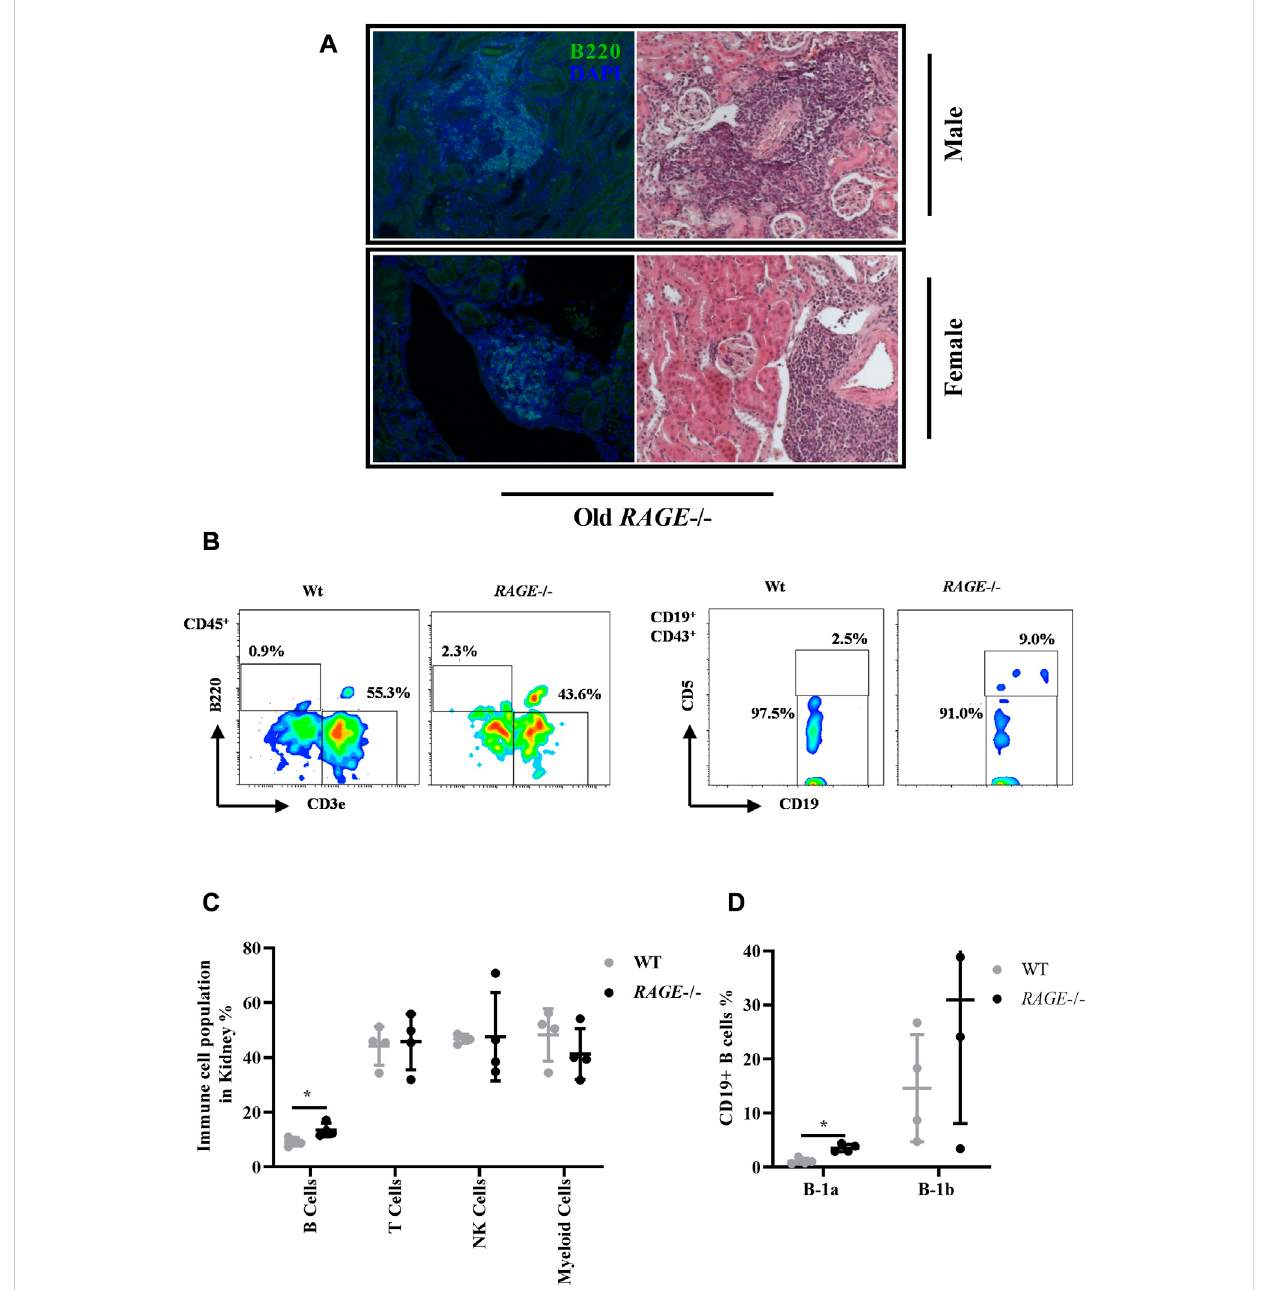
FIGURE 3 Immunecellpro fi lingofkidneytissues: (A) representativeimagesofmassivein fi ltratesinthekidneysfromoldRAGE − / − male(upperpanel)andfemale (lower panel) mice, and the in fi ltrates are stained positive for B-cell marker b220 left (green) and right. H&E of the same animal. (B) Immune cells were isolated from the whole kidney and analyzed by FACS from 62 – 68 weeks old wild type and RAGE − / − ( n = 4) (male and female combined) mice. RepresentativeFACSplots. (C) Quanti fi cationofBcells(B220),Tcells(CD3),NKcells(NK1.1),andmyeloidcells(CD11b).Populationswerecalculated as % of live CD45+ as parent gating. (D) B cells were further analyzed for B-1a (CD19+, CD43+, and CD5+) and B-1b (CD19+ and CD43+) subtypes. Population was calculated as % of live C19+ as parent gating. B220, CD19, and B-1a B cells are the dominant population in RAGE − / − , and p -values were calculated by the non-parametric t -test (Mann – Whitney test). Data are shown as mean ± SD; p- value: 0.05*, 0.01**, 0.001***, and